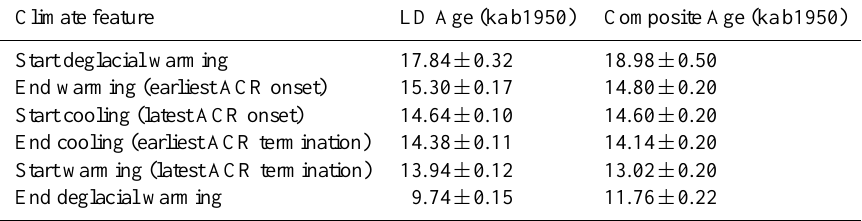
Table 4. The timing of climate features in the LD and Antarctic composite δ 18 O records derived from SiZer analysis. Dating uncertainties are the RMS sum of the dating uncertainty and uncertainty in the statistical method for picking timing of the climate feature (Sect.